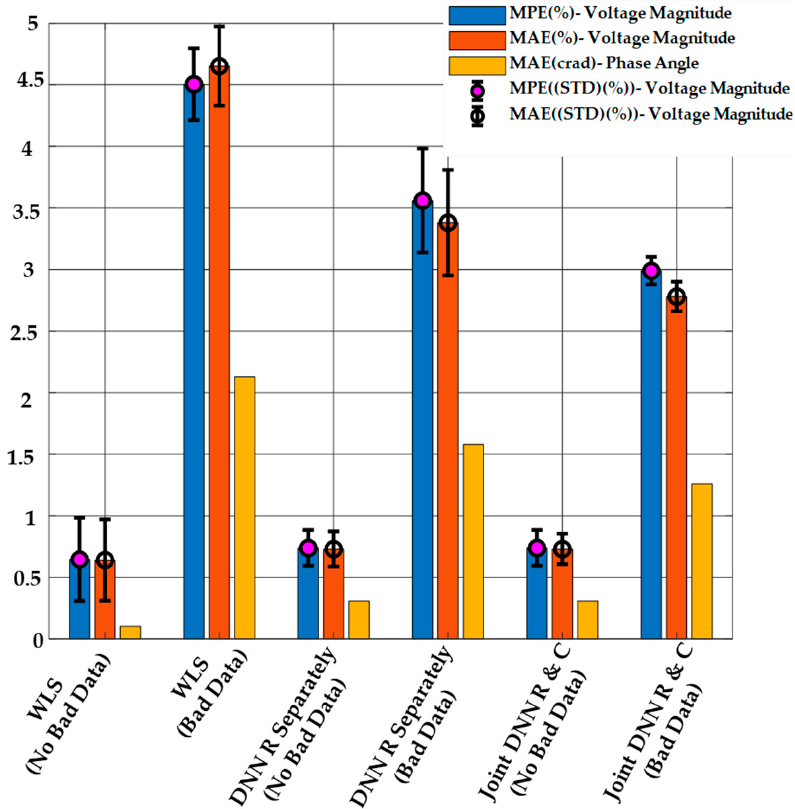
Figure 13. DSSE Results Obtained Using the Proposed Method, the Regression-only DNN Model, and WLS with or without Bad Data when N a = 876, and z a = ∼ N ( µ z , σ z )